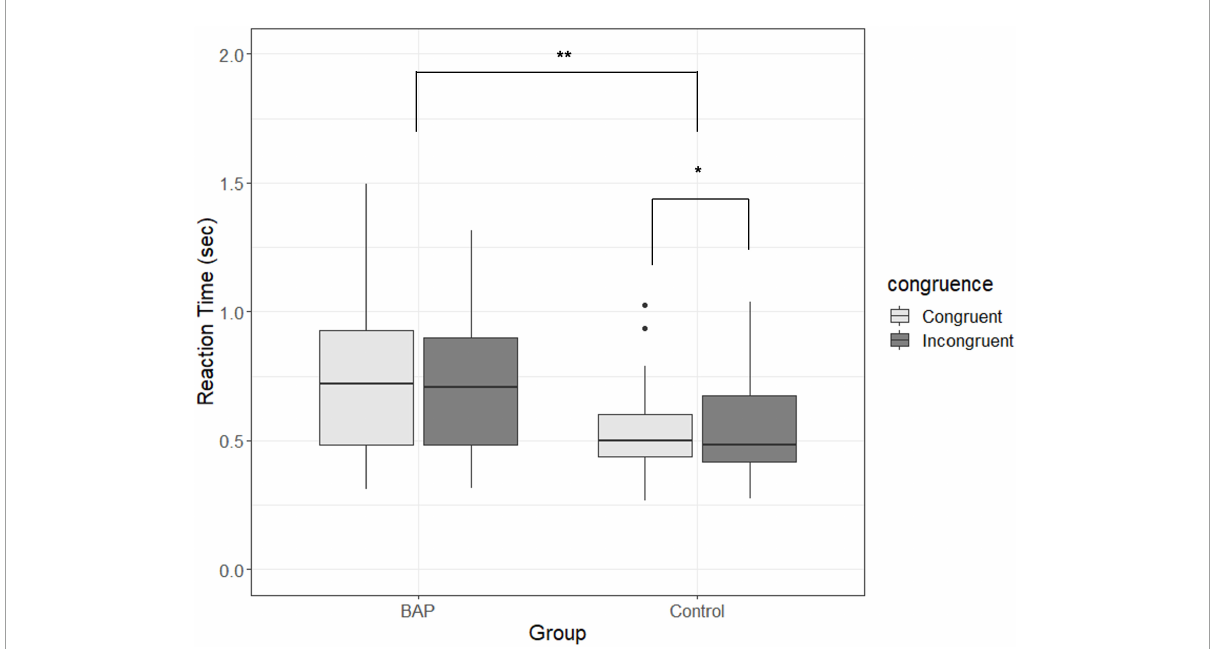
FIGURE2 Comparison of reaction time for congruence in the broad autism phenotype (BAP) and control groups. Congruent is a condition in which emotions of target and context are the same; incongruent is a condition in which emotions of target and context are not the same. Box plots show the median as the middle box line, the first quartile (Q1) and third quartile (Q3) as box edges (denoting the interquartile range, IQR), whiskers as the minimum/maximum points and outliers based on thresholds < Q1–1.5 (IQR) or > Q3+1.5 (IQR). BAP, broad autism phenotype group; Control, control group. * p < 0.05. ** p <